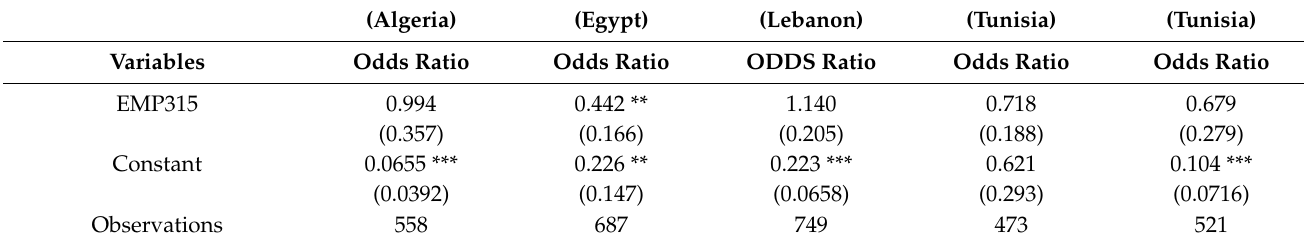
Table A7. Logistic regression on the “involvement” index by country.